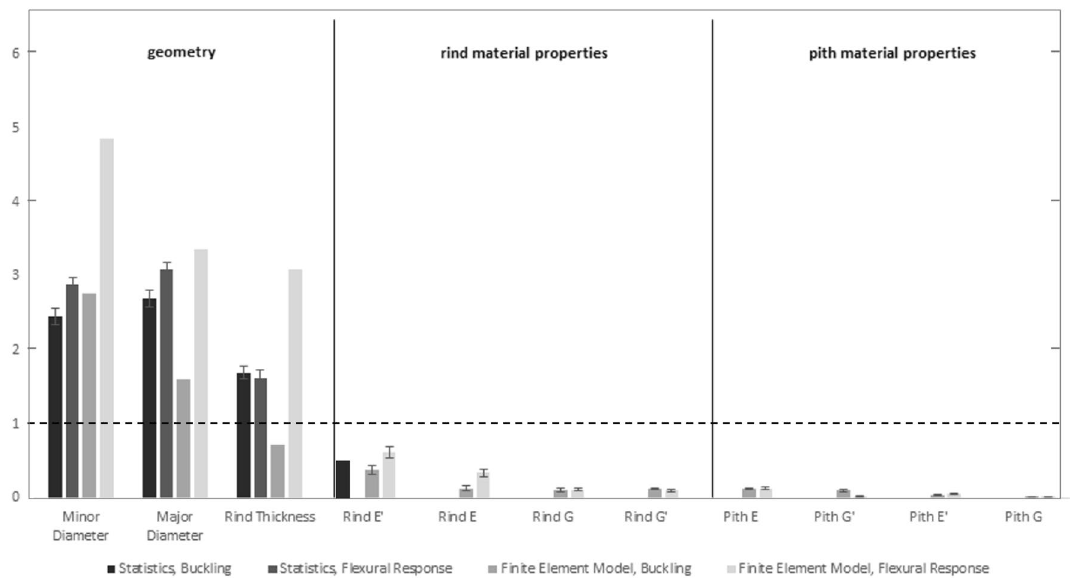
Figure 8. All sensitivities from Figs. 6 and 7 on a single plot for purposes of comparison. Empirical sensitivities are shown in dark gray shades while computational sensitivities are shown in lighter gray